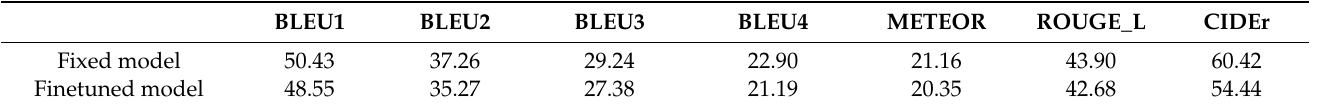
Table 6. Results of fixing and finetuning the TimeSformer